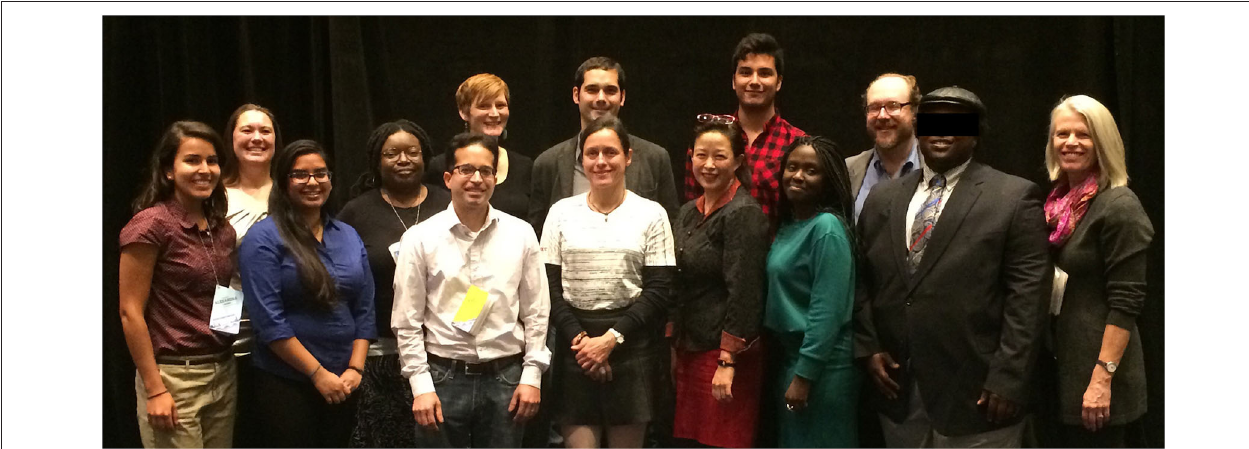
FIGURE 3 | Group photo from the 2015 ScienceWriters conference including 10 DiverseScholar SciCommDiversity Travel Fellows. The three mentors pictured are Tara Haelle (2nd from left), Maggie Koerth-Baker (6th from left), and Dr. Matthew Francis (3rd from right). DiverseScholar Advisory Board member, Dr. Cynthia-Lou Coleman, is at the far right. Mentor Nidhi Subbaraman is not pictured. Note that written informed consent was obtained from the identifiable individuals for the publication of this